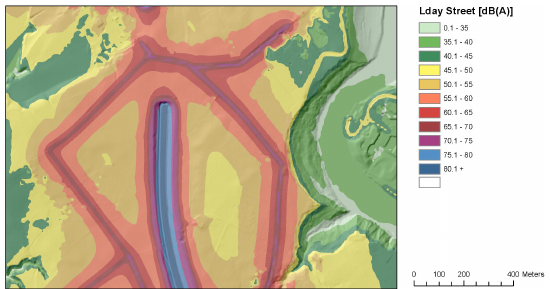
Fig. 5. Sound propagation and topography in sonBASE 2010 based on the terrain model swissALTI3D of swisstopo with a 2 × 2 meter resolution.